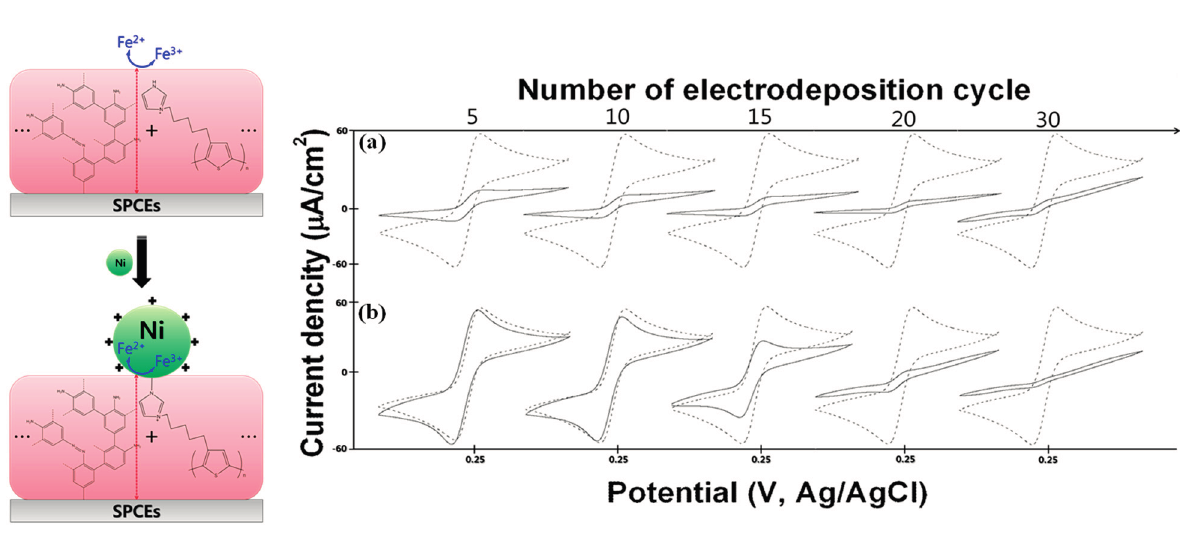
Figure 4. Cyclic voltammograms for: ( a ) SPCEs/Organic film and ( b ) SPCEs/Organic film/Ni surfaces, recorded in phosphate buffer solution containing 2 mM K 3 Fe(CN) 6 . Cyclic voltammetry was conducted at a scan rate of 100 mVs − 1 , and the voltammograms are compared to the bare SPCEs, dashed line.